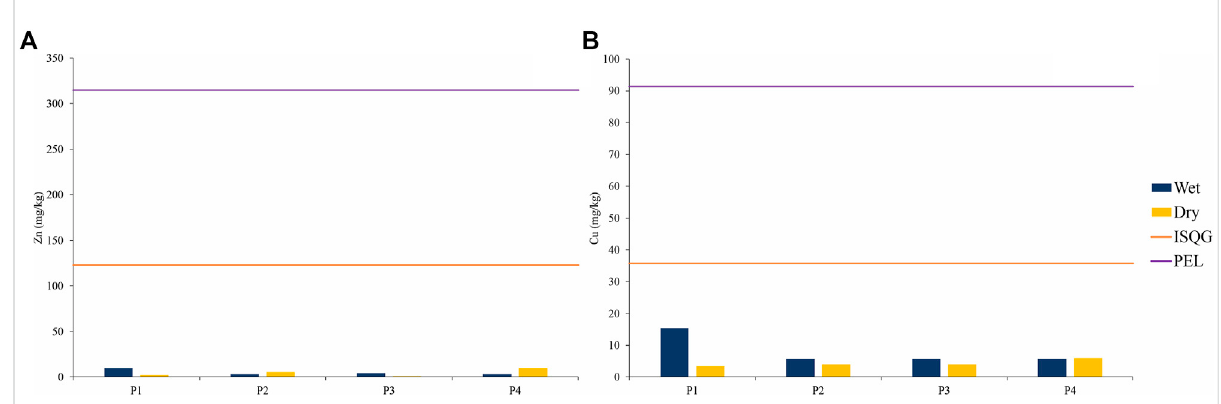
Concentration of zinc (A) and copper (B) in sediments and their contrast to the international standard: (CEQG: Canadian sediment quality standard for the protection of aquatic life in fresh waters (CCME, 2001), ISQG: interim freshwater sediment quality guidelines; PEL: probable effect